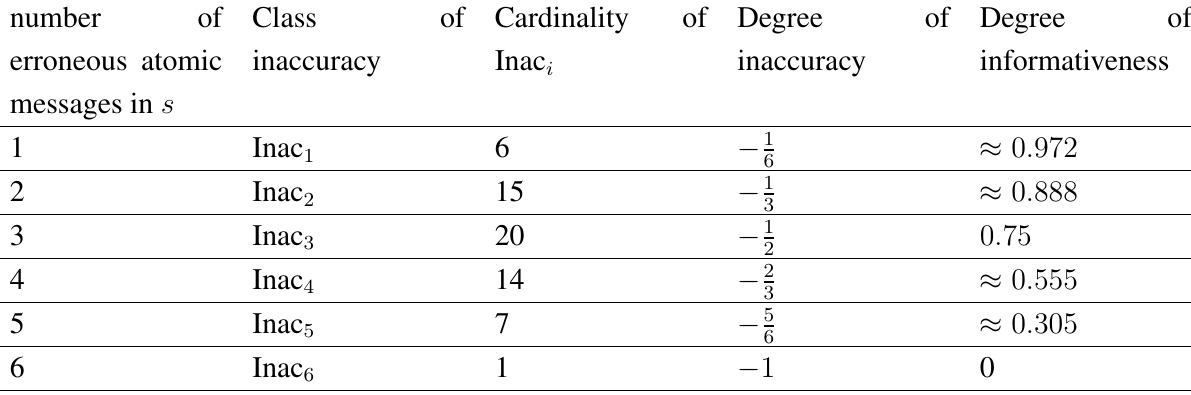
Table 1. Classes of inaccuracy.